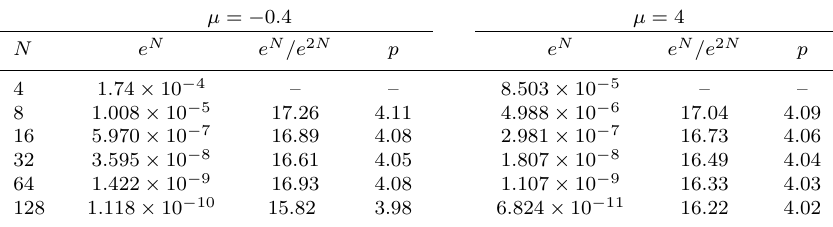
Table 2. Eq. (6.1); cubic collocation with the Chebyshev points. Maximum of errors at mesh points and convergence rates. µ = − 0 . 4 µ =